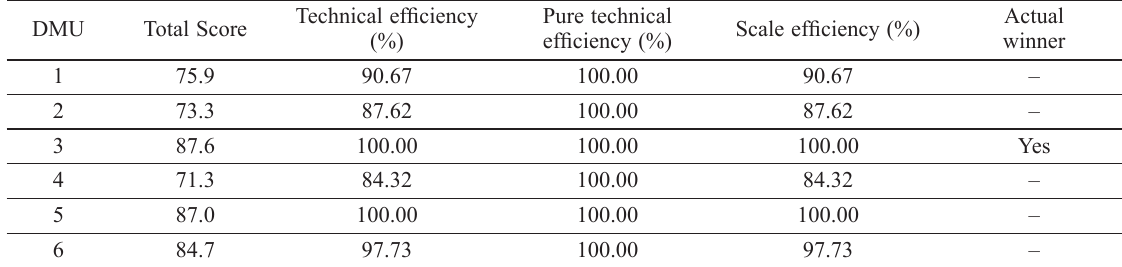
Table 7. Results of varied efficiency analysis for case project 1 DMU